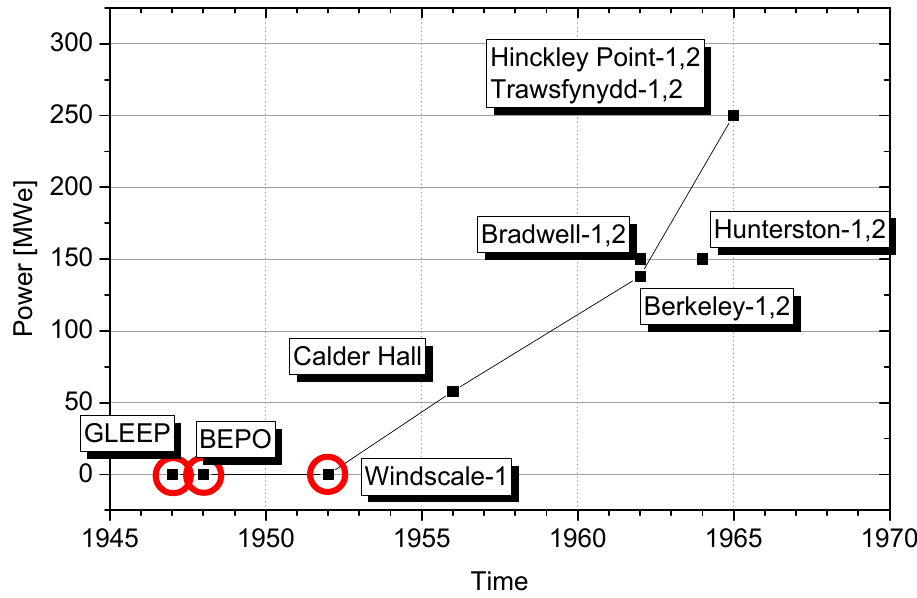
Figure 1. Development timeline of the MAGNOX technology following the data of [1].